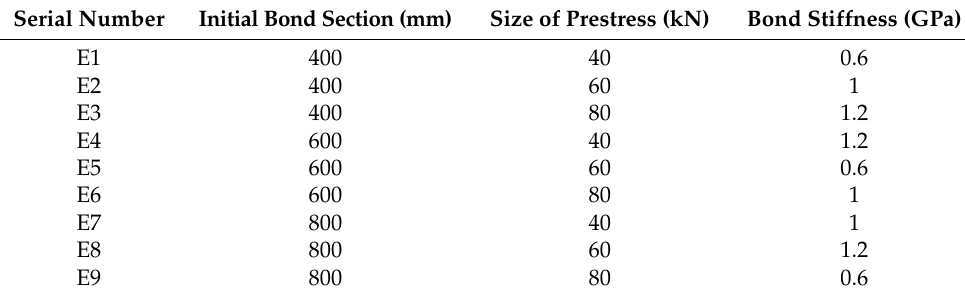
Table 2. The orthogonal test parameters.